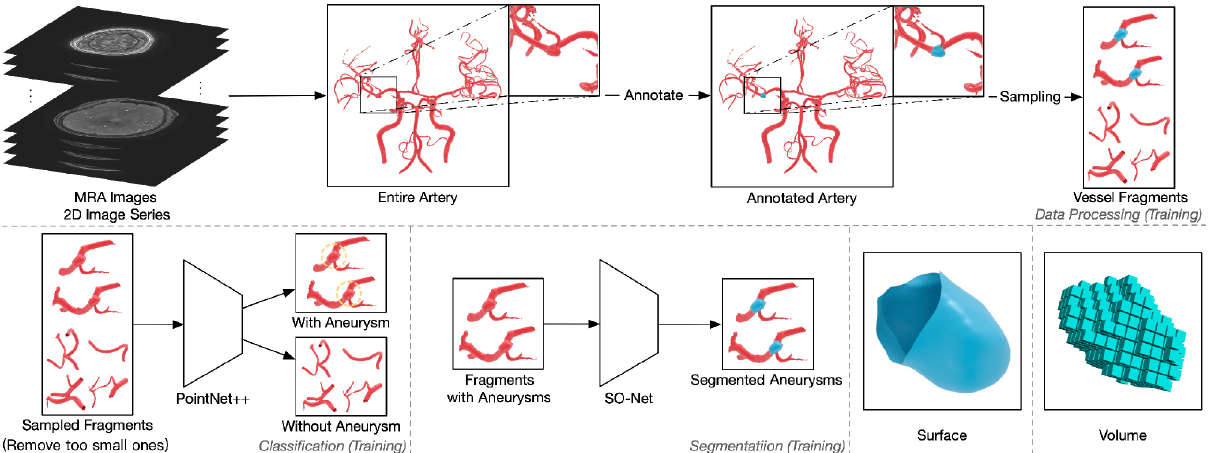
Fig. 4 Data-processing pipeline and